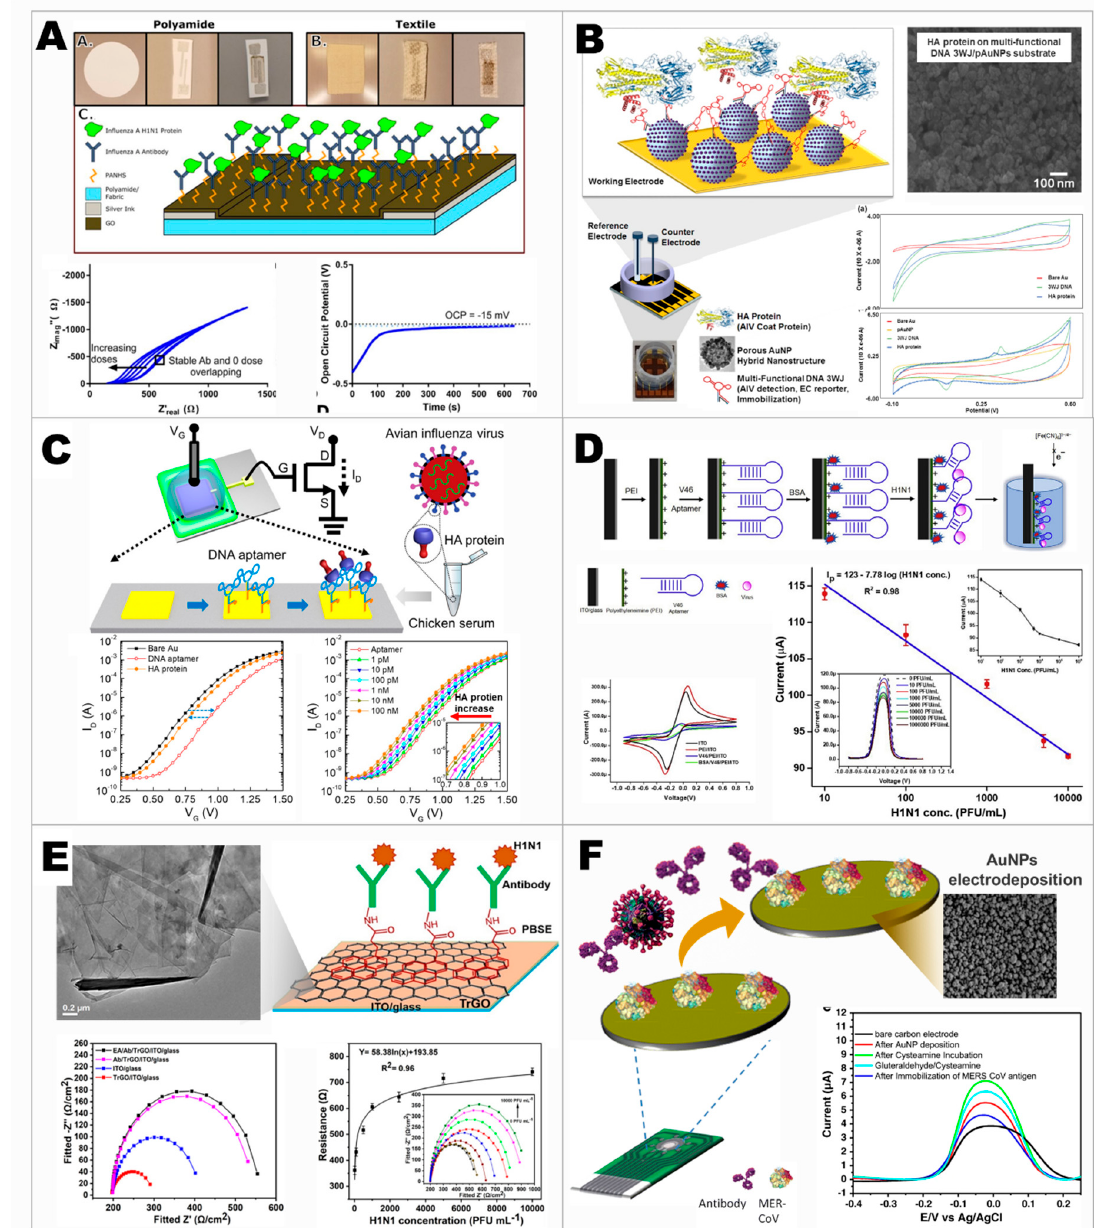
Figure 7. Examples of electrochemical sensors that have the potential for the development of point-of-care virus detection. ( A ) Wearable electrochemical biosensor for the detection of influenza virus. Adapted under the terms and conditions of the CC-BY 4.0 from [136], copyright 2018, Kinnamon et al., published by J. Electrochem. Soc. ( B ) Electrochemical biosensors for the detection of avian influenza virus (H5N1). Adapted with permission from [137], copyright 2019, Elsevier. ( C ) Aptamer-based field-e ff ect transistor for the detection of avian influenza virus. Adapted with permission from [138], copyright 2020, American Chemical Society. ( D ) Label-free electrochemical biosensors for the detection of the subtyping of Influenza A H1N1 virus. Adapted with permission from [133], copyright 2019, Elsevier. ( E ) Reduced graphene oxide-based biosensors for the detection of influenza virus. Adapted with permission from [139], copyright 2020, Elsevier. ( F ) Electrochemical array biosensors for the detection of the Middle East respiratory syndrome coronavirus (MERS-CoV) and human coronavirus (HCoV). Adapted with permission from [140], copyright 2019, Springer